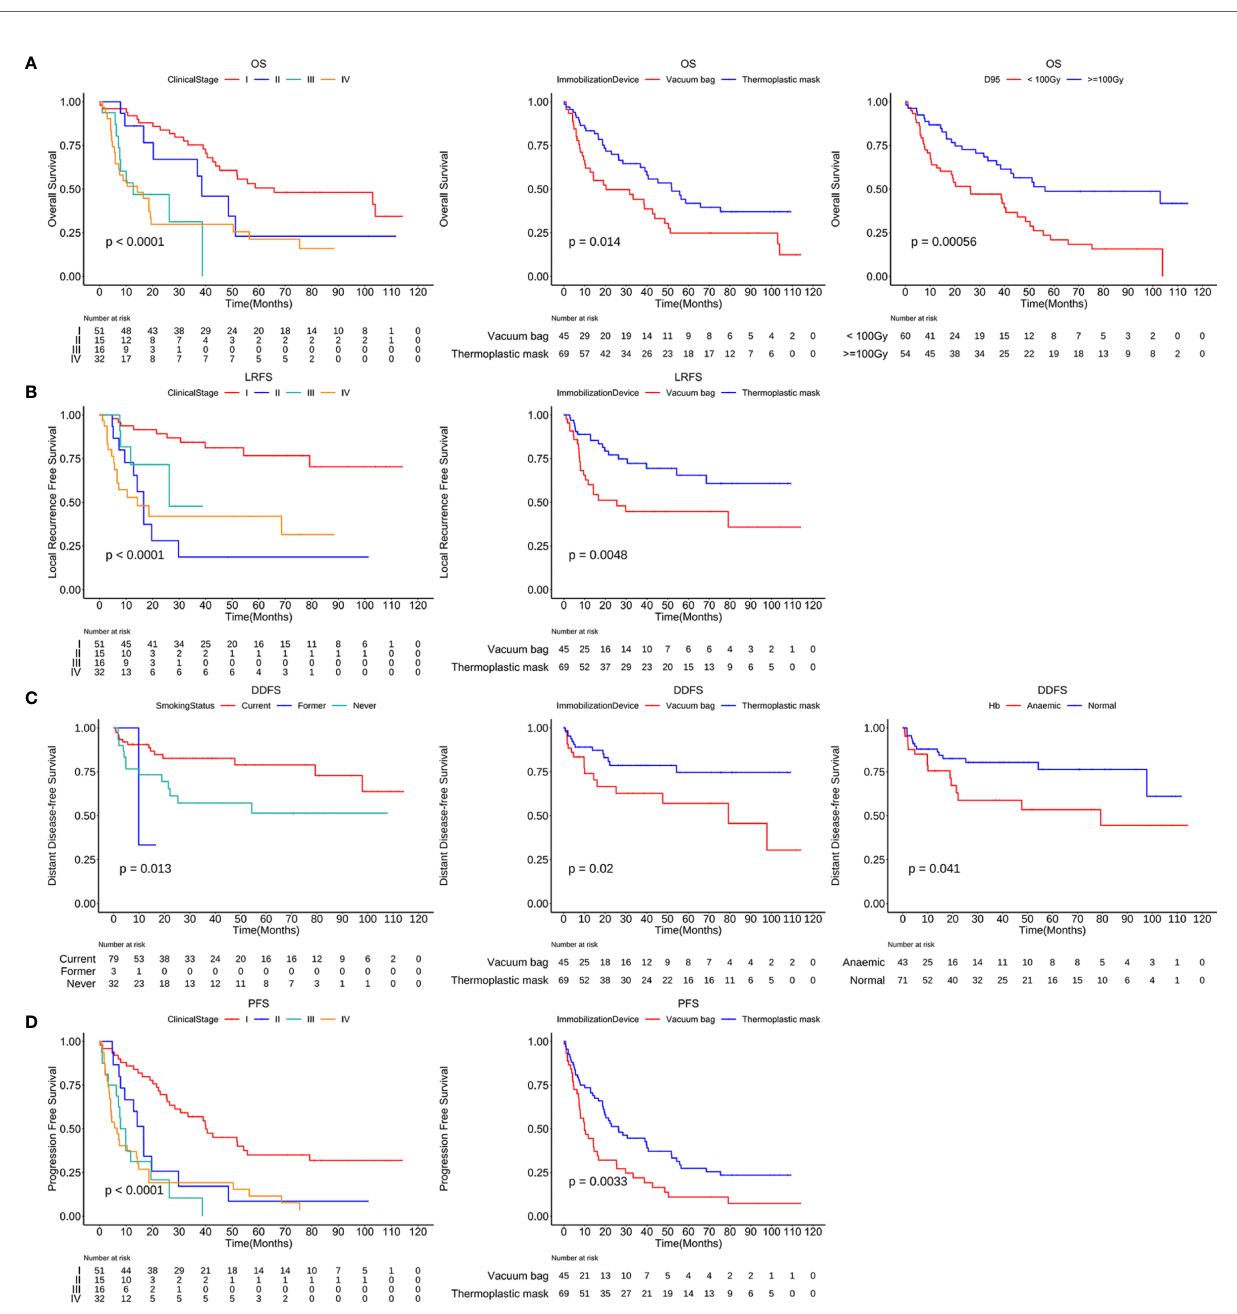
FIGURE 5 | Kaplan-Meier curves of OS, LRFS, DDFS and PFS strati fi ed by independent risk factors. OS curves strati fi ed by the clinical stage, immobilization device and D95 (A) . LRFS curves (B) and PFS curves (D) strati fi ed by the clinical stage and immobilization device. DDFS curves strati fi ed by the smoking status, immobilization device and anemia or not (C) . D95, the prescription dose covers 95% of the target area; OS, overall survival; LRFS, local recurrence free survival; DDFS, distant disease-free survival; PFS, progression free